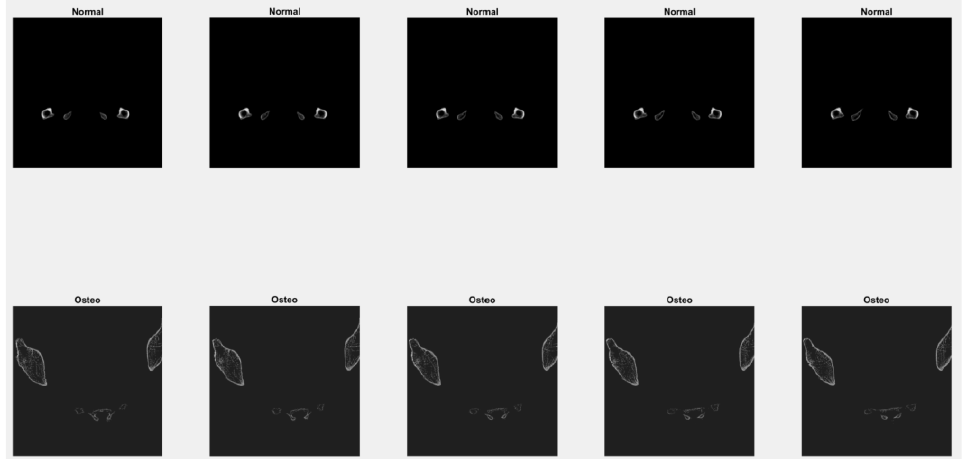
Figure 8. Samples of images for the training and testing stages of the bone classification study using CNN.